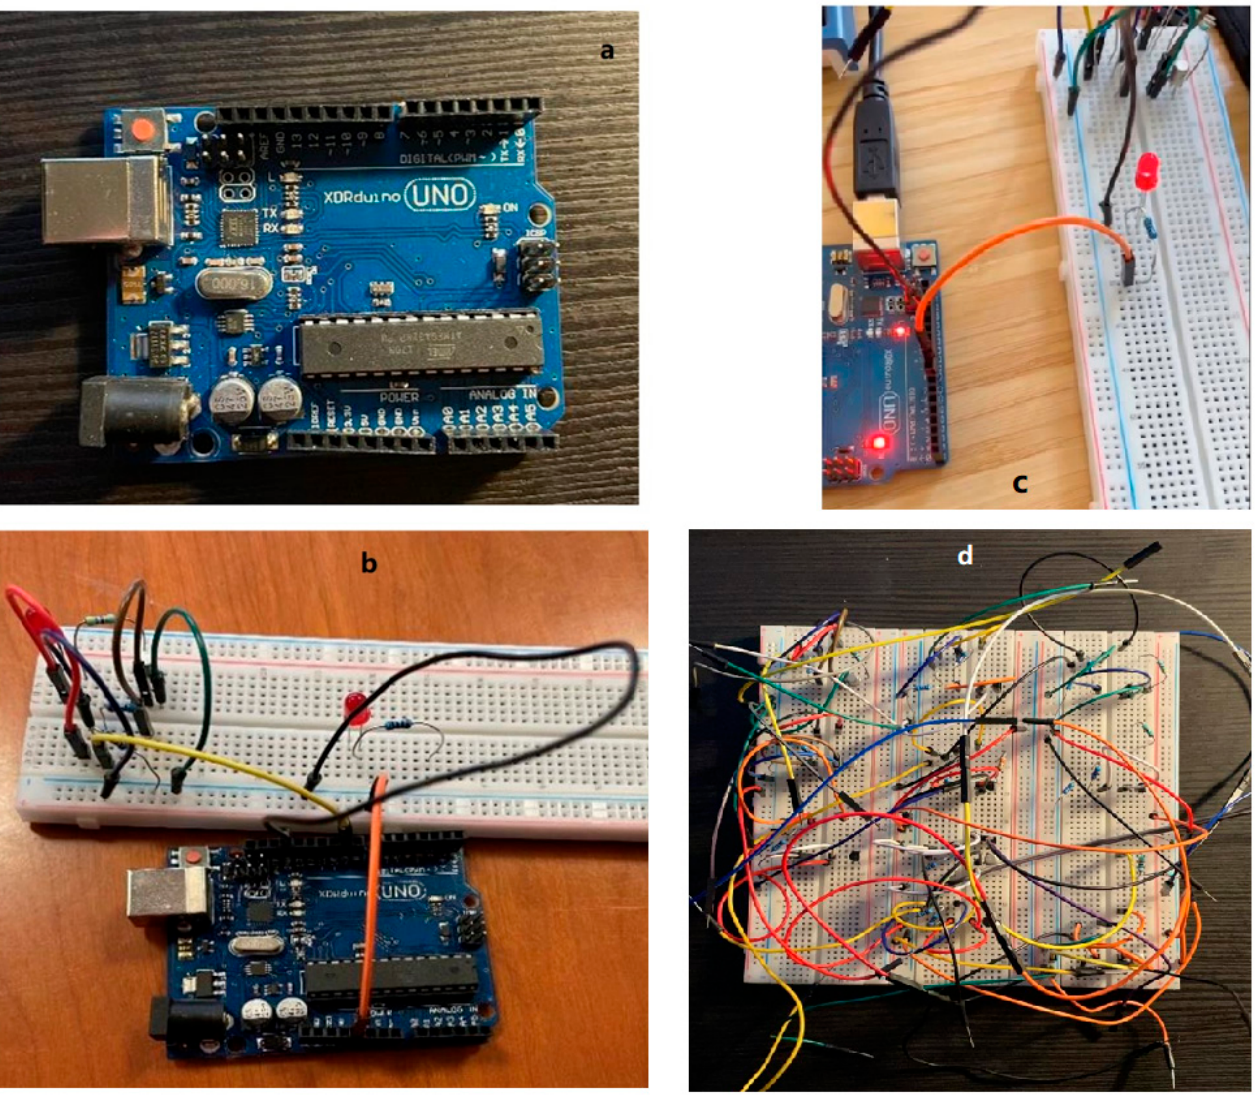
Figure 3. Arduino device used in this study ( a ), Arduino connected with UV-LED circuit ( b ), Ar- duino with LED On ( c ), fully assembly UV-LED Circuit ( d